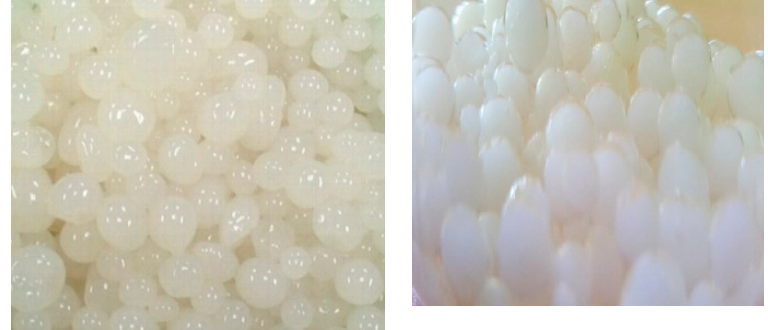
Figure 5. Gellan gum microbeads of Enterobacter sp. strain BRC05 before and after 24-h cycle